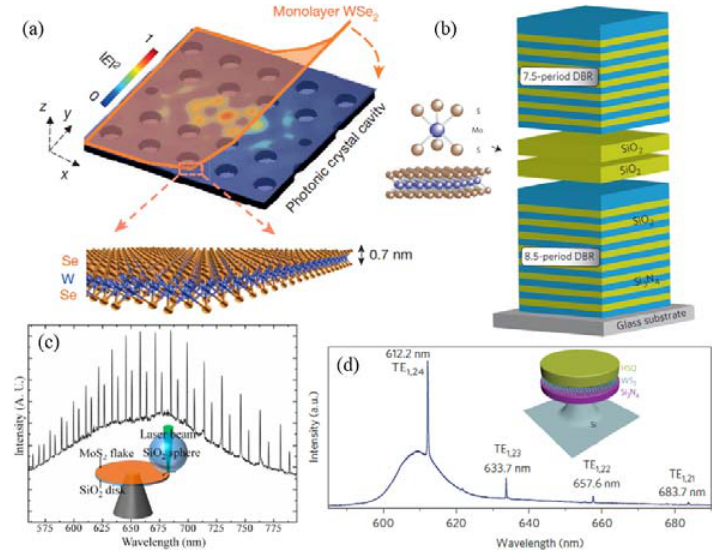
Figure 17. ( a ) Illustration of PPC architecture, where the electric ‐ field profile (in ‐ plane, x ‐ y) of the fundamental cavity mode (pristine cavity before WSe 2 transfer) is embedded as the color plot. microcavity structure, a monolayer of MoS 2 , sandwiched between two SiO 2 layers to form the cavity